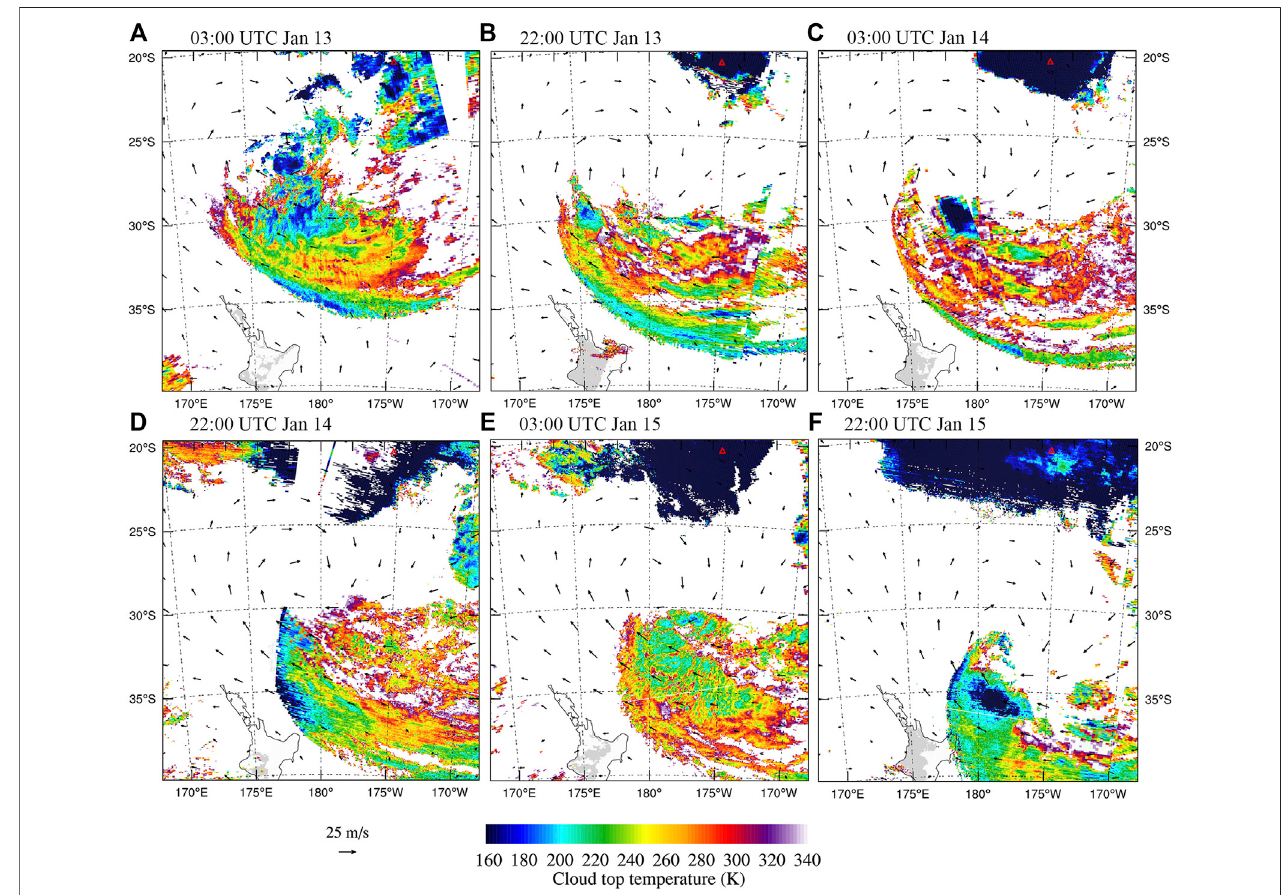
FIGURE 1 | Cloud top temperature from the MODIS and wind fi eld at 10 m of ERA5. Red triangles indicate the location of the Tonga volcano. The UTC time and date is on each panel from (A – F) .